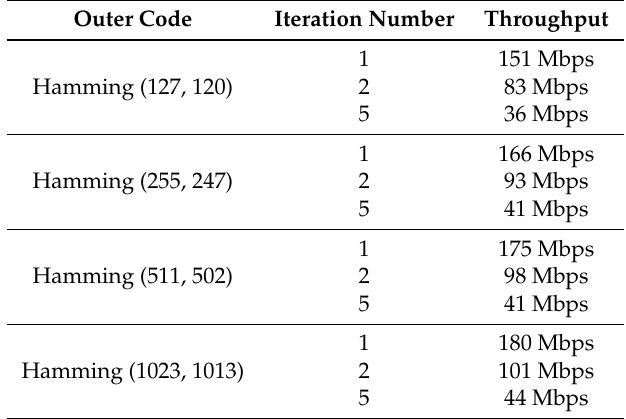
Table 1. Throughput of the iterative decoders for different product codes. Outer